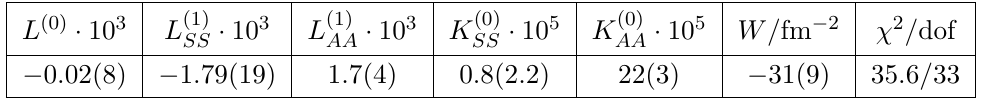
Table 8 . Results of a global fit to the energy shift in U(4) ChPT. The goodness of the fit is ilustrated in figure